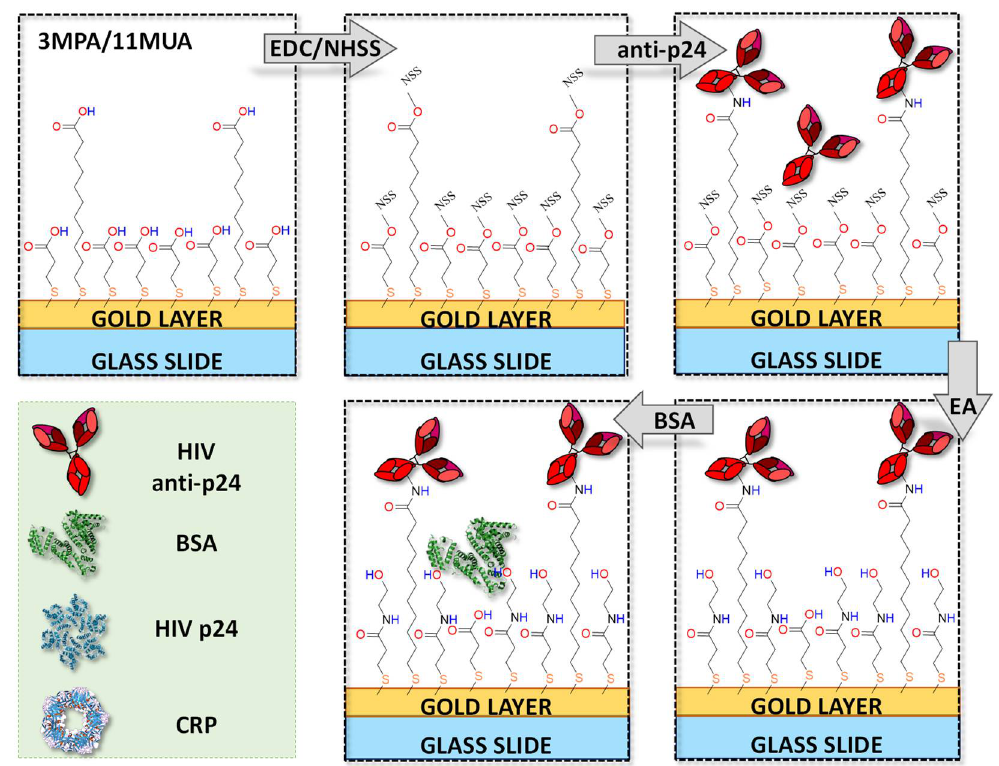
Figure 3. Schematic representation of the anti-p24 covalent bonding on the mixed SAM (3MPA/11MUA) on gold (not in scale). The inset on the left side reports a legend of all the biorecognition elements and analytes involved in the sensing and negative control experiments.